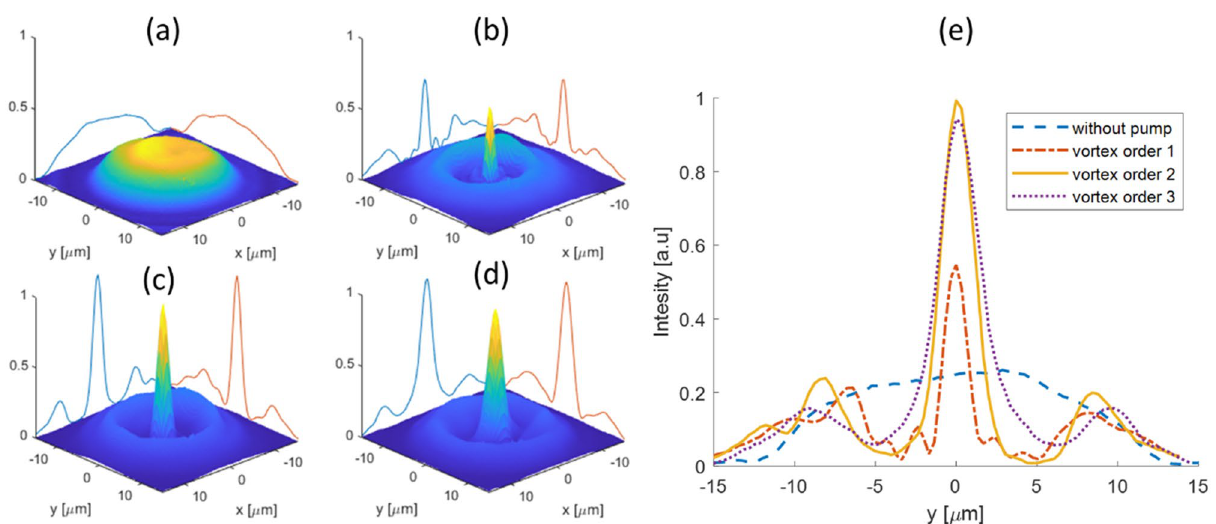
Figure 4. The effect of donut pump diameter on the IR probe beam focusing. Images of the probe beam, without pump beam ( a ), and with donut pump with vortex orders 1, 2, and 3 applied on the pump beam are shown in ( b )–( d ), respectively. In ( e ) are shown the profiles of the probe beam under the different vortex orders for the donut pump beam. The best focusing is in vortex order 1. For higher vortex orders, the probe PSF is wider moderately but stronger. The blue curve is the probe PSF without the pump beam, and one can see the dramatic improvement in the PSF of the probe beam with the application of the donut-shaped pump